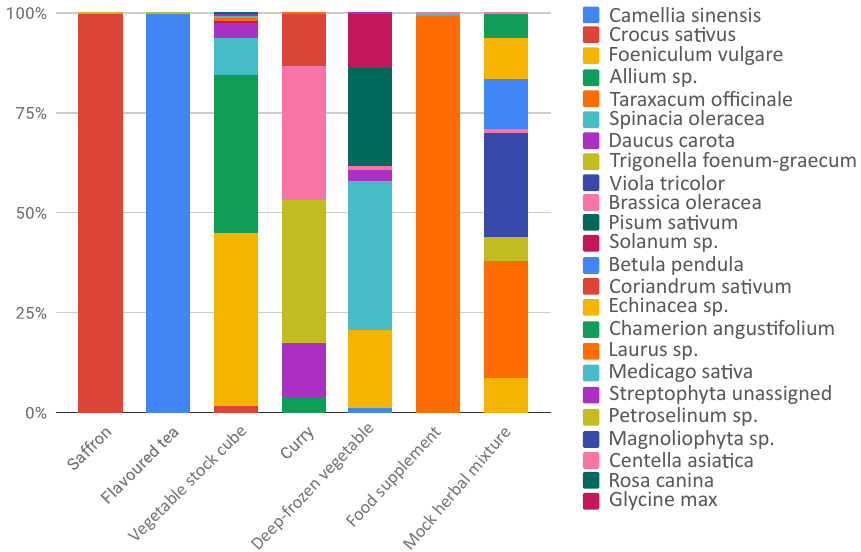
Figure 2. Taxa barplot reporting relative abundances of plants detected in processed